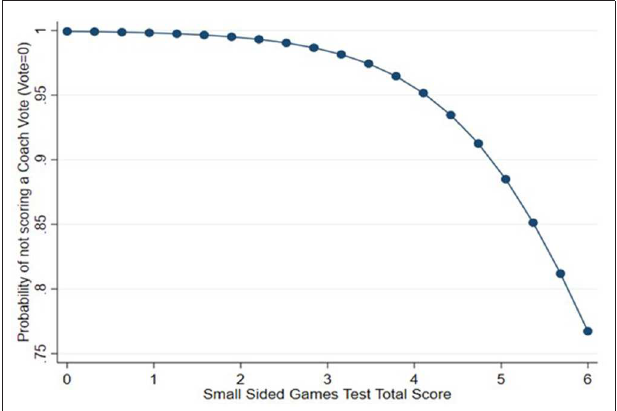
FIGURE 1 | The probability of not scoring a coach vote in relation to small sided games test score.